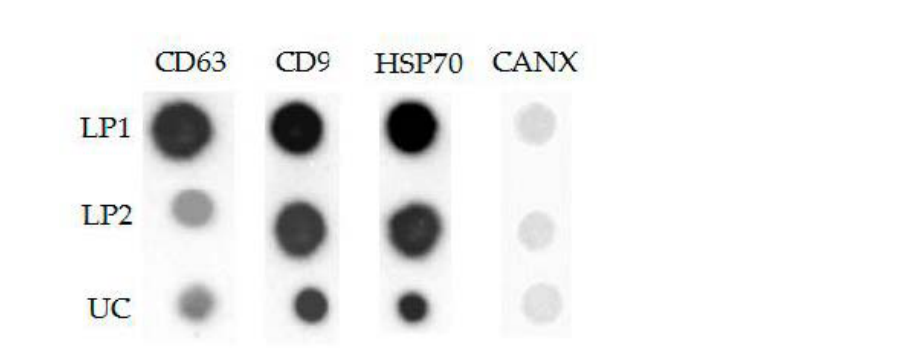
Figure 9. Exosomal marker evaluation in lower phases of PTPS and UC-ENV by dot blot.